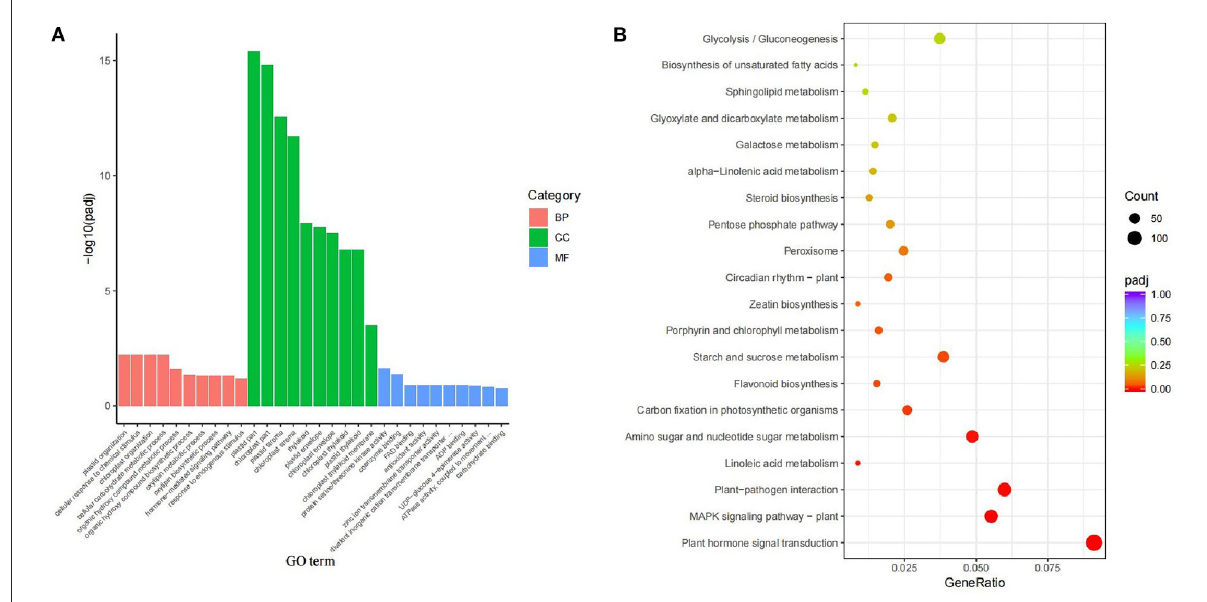
FIGURE4 GO enrichment and KEGG enrichment of differentially expressed genes in diploids and autotetraploids of Pisang Berlin. (A) GO enrichment and different colors represented different functional categories, including BP biological processes, CC cellular components, and MF molecular functions. (B) KEGG enrichment and gene ratio represented the ration of the number of differentially expressed genes to the total gene number in the specific pathway, green indicated a low Q -value, while red indicated a high Q